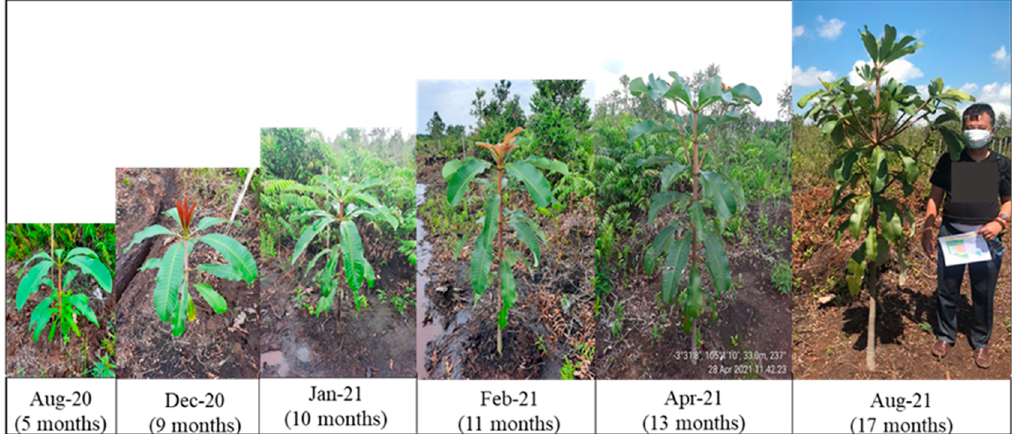
Figure 5. Growth performance of Dyera polyphylla in degraded peatland 17 months after transplanting in the field, South Sumatera, Indonesia. (Photo credit: Bastoni). Table 3. Revegetation trial activities and development forest plantation in degraded ecosystem peat swamp forests in Indonesia.